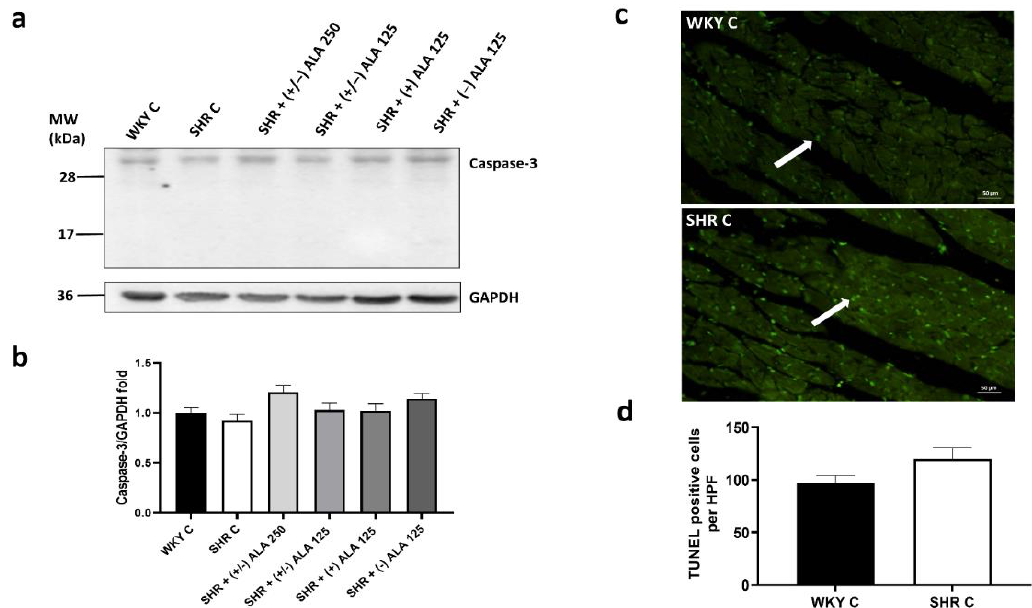
Figure 7. Apoptosis in heart. ( a ) Lysates of heart from WKY C, SHR C, SHR + (+/ − ) alpha lipoic acid (ALA) 250 µmol/kg/day, SHR + (+/ − ) ALA 125 µmol/kg/day, SHR + (+) ALA 125 µmol/kg/day, SHR + ( − ) ALA 125 µmol/kg/day were immunoblotted using specific anti caspase-3; ( b ) The bar graph indicates the ratio of densitometric analysis of bands and GAPDH levels used as loading control, considering the WKY C group as reference. Blots are representative of one of three separate experiments; ( c ) Sections of heart from WKY C and SHR C processed for TUNEL staining. Arrow: apoptotic nucleus. Calibration bar 50 µm; ( d ) The bar graph shows the quantification of the number of positive cells per high-power field (HPF) (20×). Data are mean ± S.E.M.